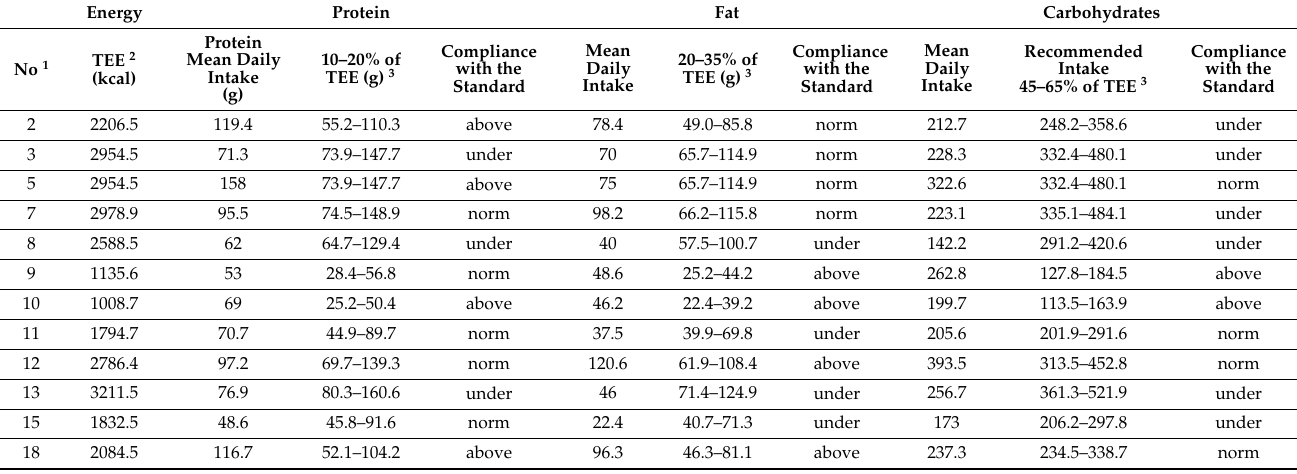
Table 4. Assessment of macronutrient intake in subjects with ID with abnormal body mass with reference to Total Energy Requirement (TEE) calculated for appropriate body